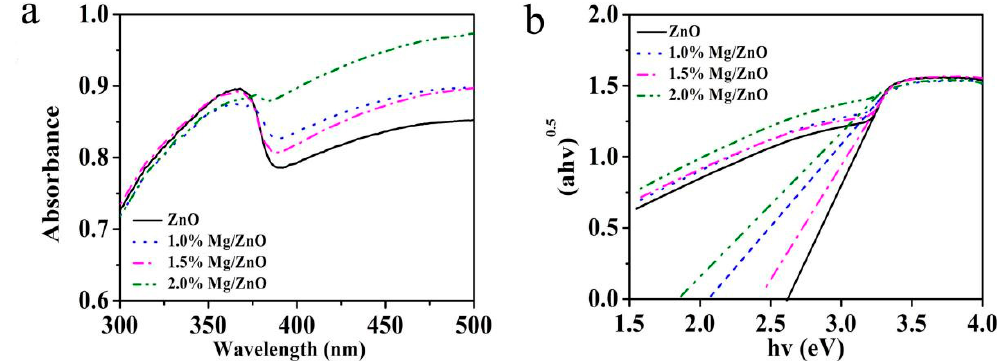
Figure 5. UV-Vis absorption spectra ( a ) and the band gap energy ( b ) of the Mg-doped ZnO with different Mg contents.